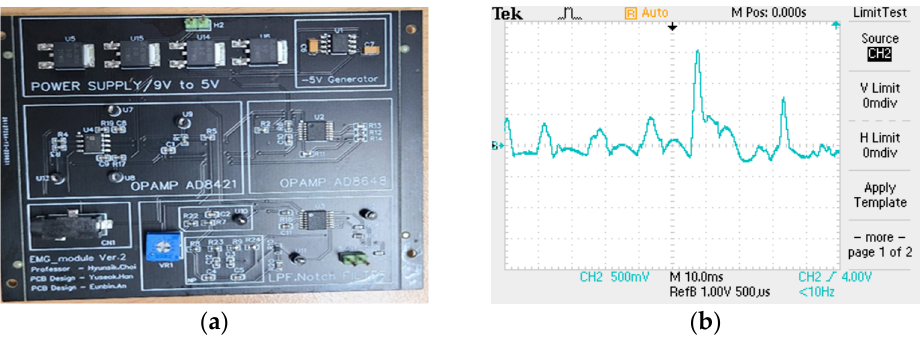
Figure 1. ( a ) Prototype for electromyogram (EMG) sensor and ( b ) measurement results in the wrist.